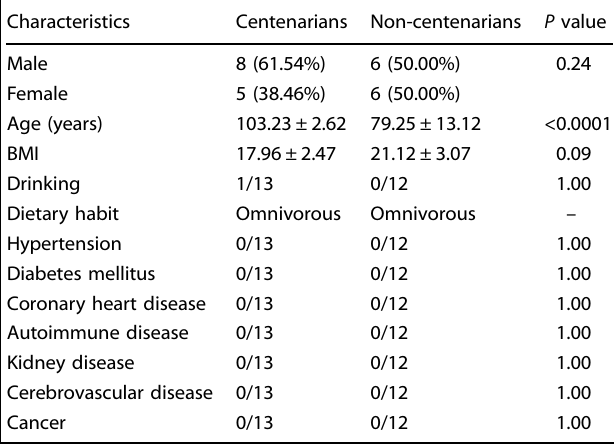
Table 1. Demographics of the Hainan longevity